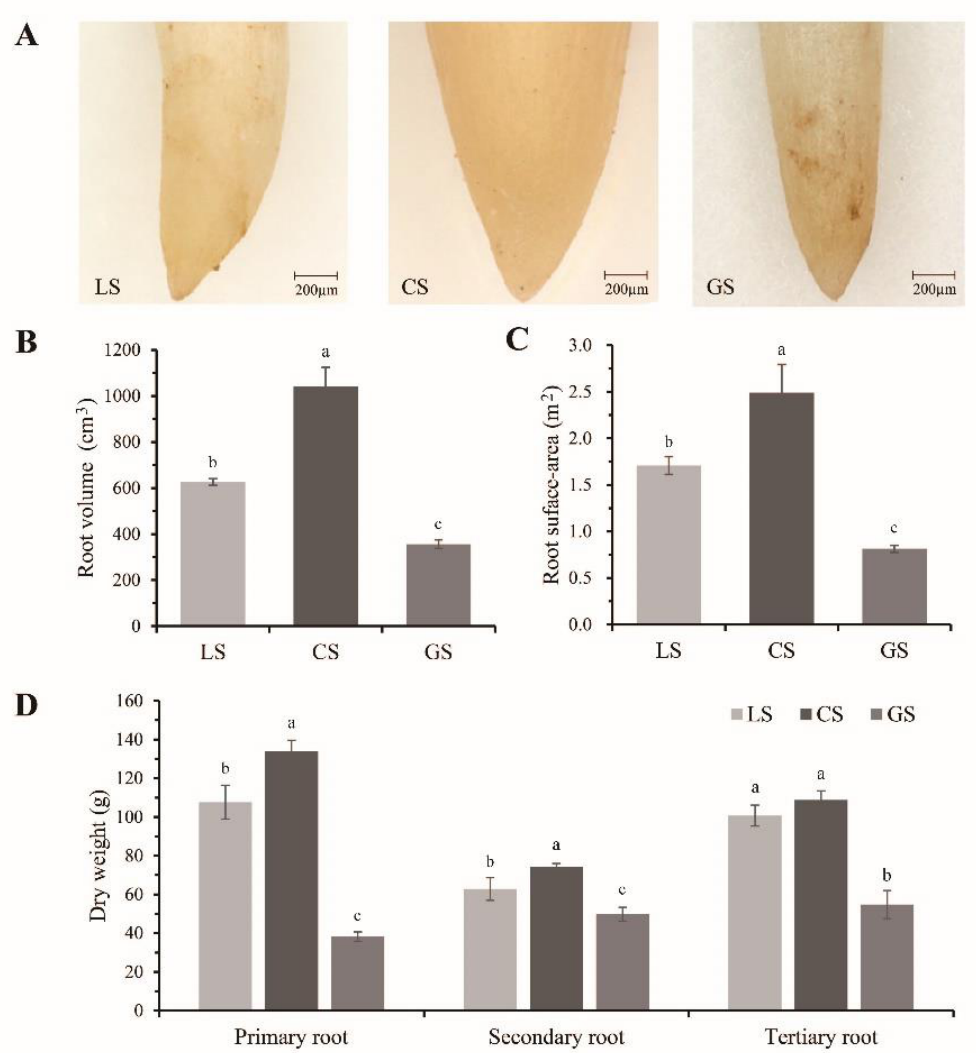
Figure 2. Root tip development of D. odorifera under three growth substrates: ( A ) the representative morphology of root tip; ( B ) total root volume of plants; ( C ) total root surface area of plants; and ( D ) dry weight of primary root, secondary root, and tertiary root of plants. LS: loam substrate, CS: composite substrate (50% gravel), and GS: gravel substrate (100% gravel). Error bars represent the SD of the mean. Different lowercase letters indicate a significant difference with the p value < 0.05.